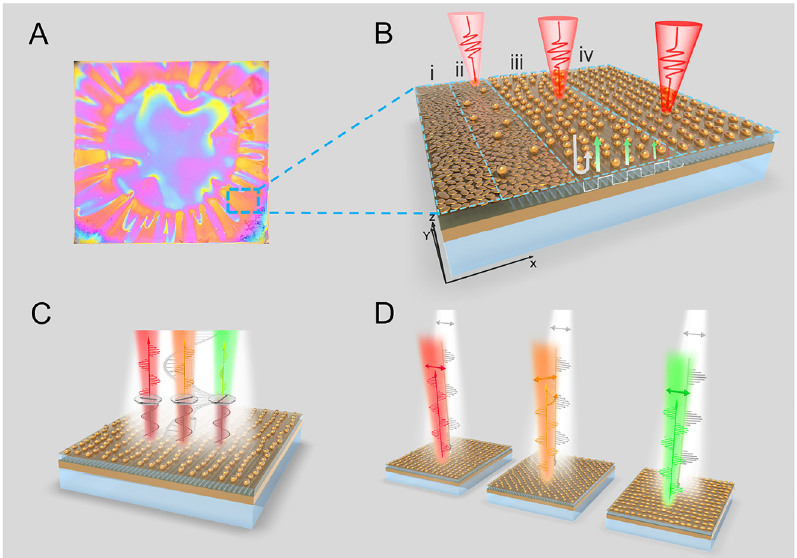
Figure 1: Regulating disordered plasmonic nanoparticles into nanogratings for polarization sensitive color display. (A) Structural colors exhibited by disordered Au nanoparticles deposited on a non-uniform polymer (PMMA) film coated on a thin Au film. (B) Schematic showing the evolution of the disordered Au nanoparticles induced by increasing the laser fluence and the formation of a nanograting composed of regularly arranged elliptical Au nanoparticles. (C) Schematic showing the observation of different structural colors in the reflected light of a nanograting irradiated with unpolarized white light by rotating the polarization analyzer. (D) Schematic showing the preservationor rotationof the polarization stateof the incidentlight inthe reflectedlight,dependingon thepolarization angleof the incident light with respect to the vector of the